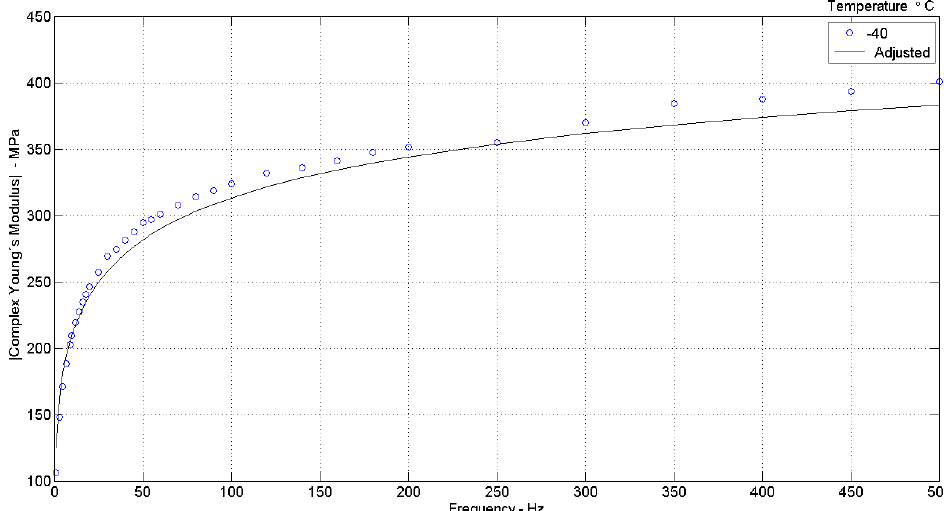
Figure 2. Variation of Complex Young’s modulus (experimental data “o”) for (adjusted curve by model parameters “ − ”), T = − 40 ◦ C, ε = − 0.05 ( λ = 0.95) [29].